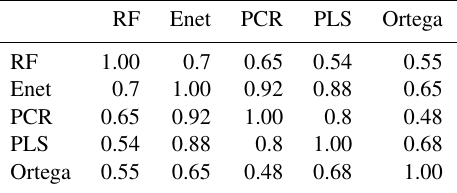
Table 1. Table of correlations between five reconstructions: Or- tega et al. (2015) reconstruction; RF reconstruction for the period 1000–1972 using the proxy records significantly correlated with the NAO at the 80% confidence level; Enet reconstruction for the pe- riod 1000–1972 only using the proxy records significantly corre- lated with the 95% confidence level; PCR reconstruction for the period 1000–1970 only using the proxy records significantly corre- lated with the NAO at the 95% confidence level; PLS reconstruction for the period 1000–1970 only using the proxy records significantly correlated with the NAO at the 95% confidence level. RF Enet PCR PLS Ortega RF